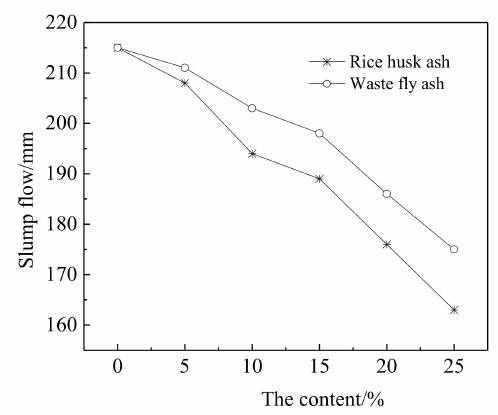
Figure 4. The slump flow of fresh